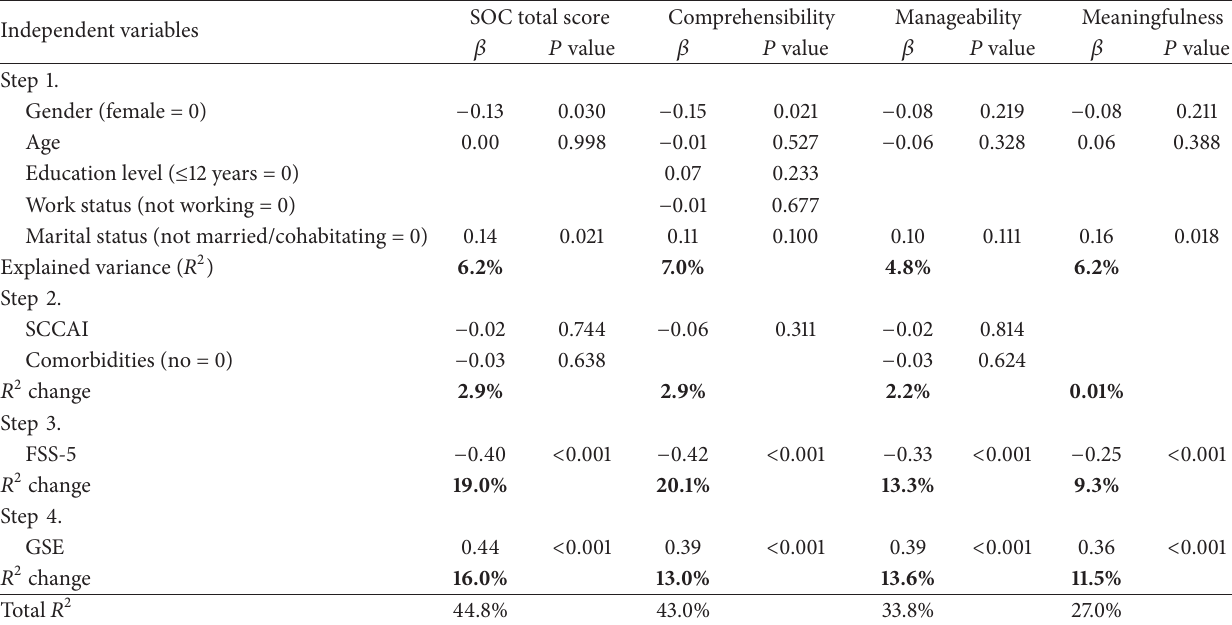
Table 4: Four independent linear regression analyses with SOC total and subdimension scores as dependent variables in patients with ulcerative colitis ( 𝑛 = 190